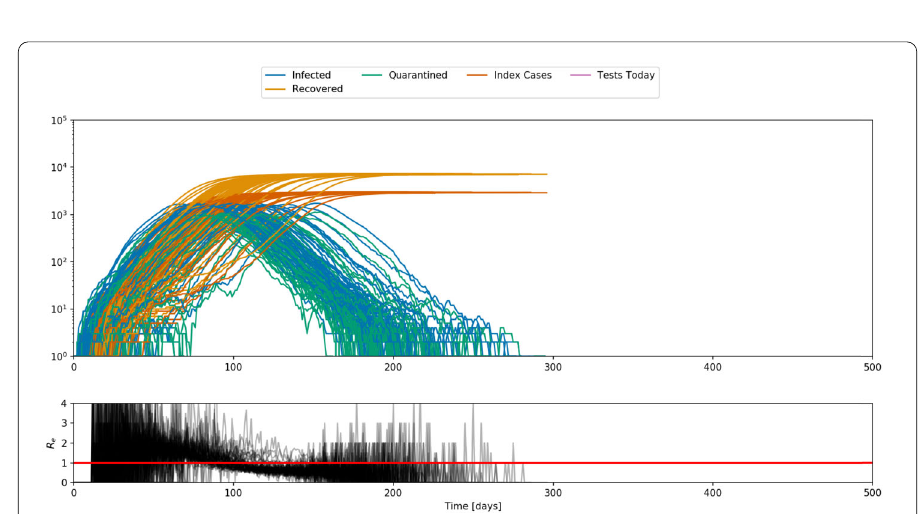
Figure 20 Outbreak dynamics when someone with zero days latency period can infect others on the day he or she became